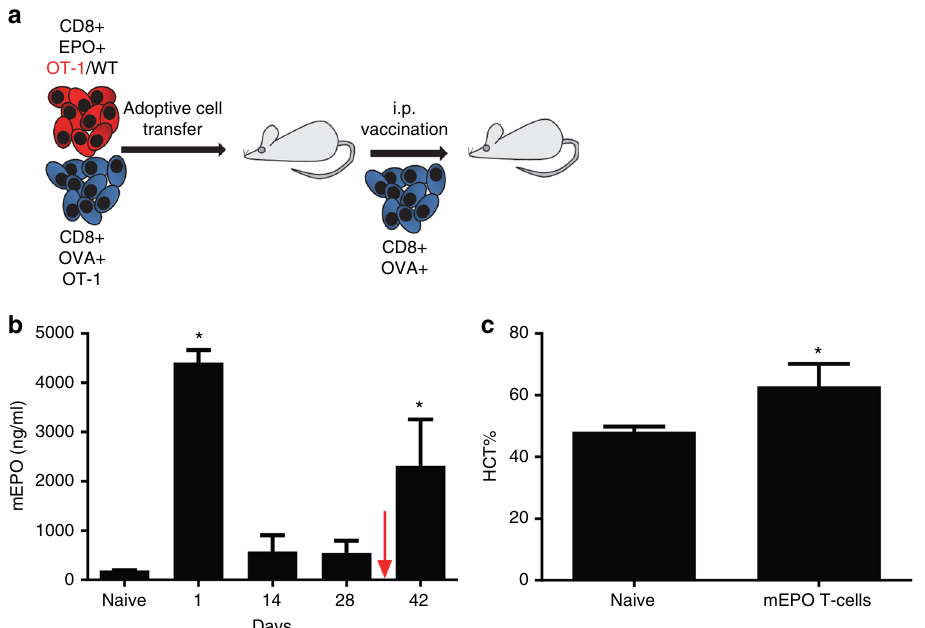
Fig. 5 EPO delivery in vivo by EF1 α -mEPO transposon-modi fi ed T lymphocytes. a Schematic representation of experiment evaluating ability of adoptively transferred transposon-modi fi ed T lymphocytes to produce EPO following adoptive cell transfer. b Graph of plasma EPO concentration in the days following ACT of 2 × 10 7 million EF1 α -mEPO transposon-modi fi ed T lymphocytes. Statistical analysis was performed by comparing two pre-treatment levels using one-way ANOVA with multiple comparisons ( N = 5 ± SEM). Red arrow indicates administration of cellular vaccine at day 41. c Graph comparing hematocrit 6 weeks after ACT (mice from b ) to that of untreated control mice. The mean hematocrit of treated mice was 62.8 ± 3.2 ( N = 5 ± SEM) and untreated mice was 47 ± 1.4 ( N = 6 ± SEM), * p < 0.05 using Student ’ s T